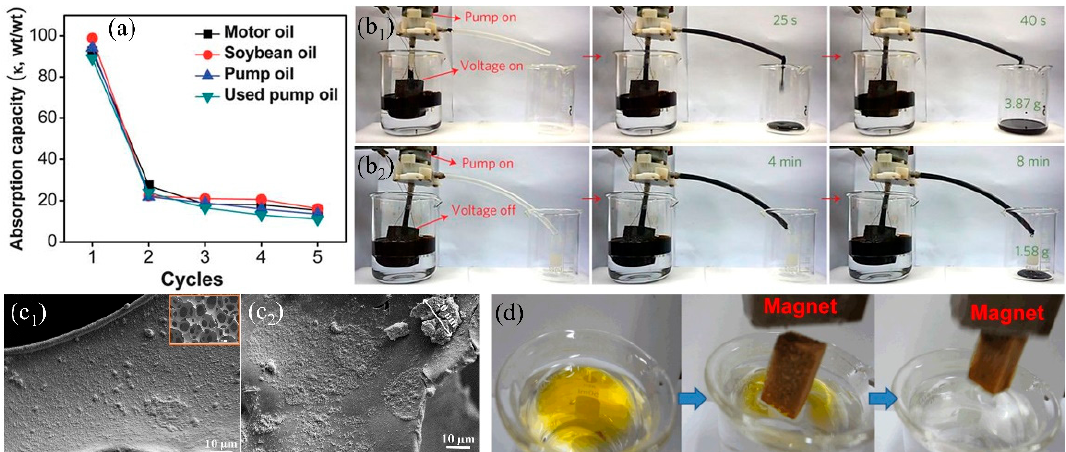
Figure 9. ( a ) Absorption recyclability of the sponge modified with graphene for oils [156]. ( b ) Comparison of efficiency of the viscous crude oil continuous collection device: ( b 1 ) applied voltages of 17 V, ( b 2 ) applied voltages of 0 V [157]. ( c ) SEM images of the PU sponge modified by hydrophobic SiO 2 , ( c 1 ) and un ‐ hydrophobic SiO 2 ( c 2 ) [130]; reproduced with permission from Springer. ( d ) Photograph of the Fe 3 O 4 melamine sponge absorbs the oil (yellow) by magnetic driven [69]; reproduced with permission from Elsevier.